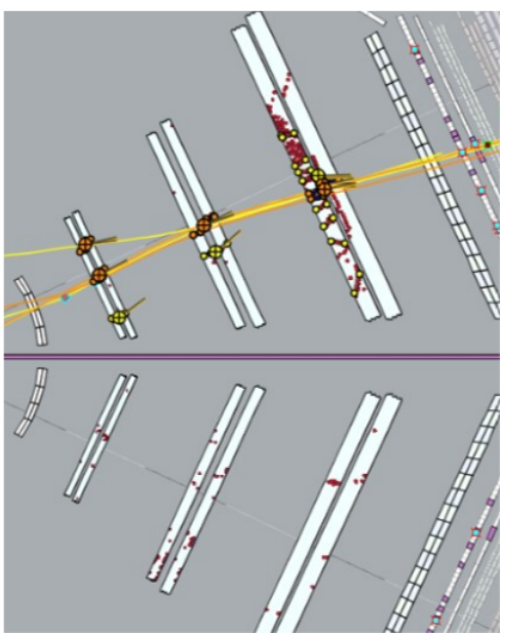
Figure 4. An example of how spurious hits increase combinatorics leading to, in this case, four track combinations being considered even though there are actually